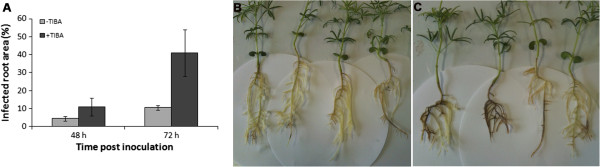
Negative effect of auxin transporter inhibitor (TIBA) onPhytophthora cinnamomiresistance in lupin. The effect of TIBA; an auxin transport inhibitor on lesion development in Lupinus angustifolius roots inoculated with Phytophthora cinnamomi mycelial plugs. (A) Percentage infected root area in TIBA-treated (+TIBA) and non-TIBA-treated (−TIBA) lupin roots 48 h and 72 h after inoculation. (B) and (C) show disease symptoms caused by P. cinnamomi infection in non-TIBA-treated (B) and TIBA-treated (C). One way ANOVA indicated a significant (P < 0.001) difference between treatments.